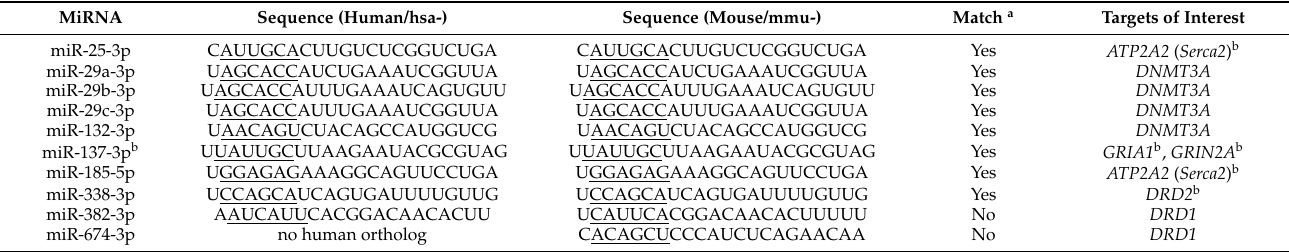
The seed sequence is underlined in each miRNA sequence. a Yes: indicates miRNA sequence is identical in human and mouse; No: indicates species difference. b Ripke et al., 2014: 108 loci associated with